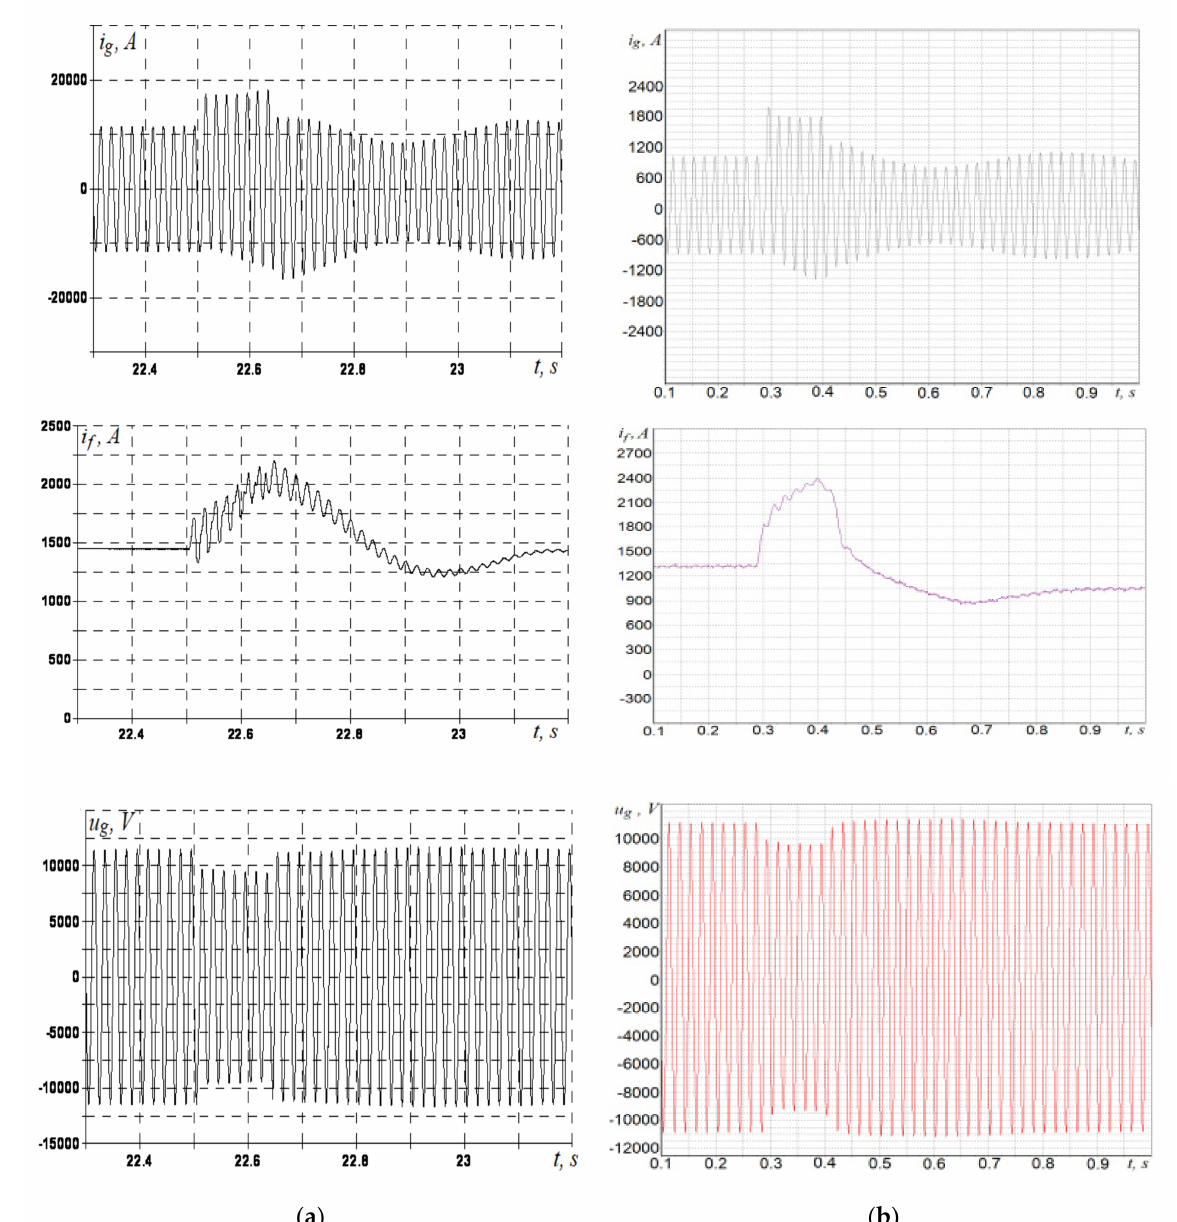
Figure 7. ( a ) Simulation in the hybrid system; ( b ) experimental results of the stator current ( i g ), field current ( i f ), and phase voltage of the generator ( u g ) for the one-phase short circuit on the power